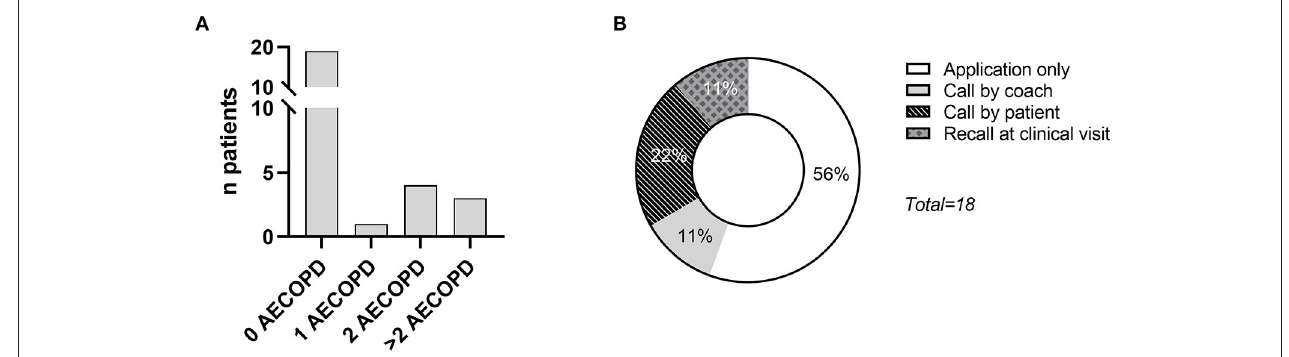
FIGURE 2 | (A) Distribution of the occurrence of COPD exacerbations (AECOPD) in patients who completed the 6 months follow-up ( n = 27); (B) distribution on how the COPD exacerbation was first reported to the coach.